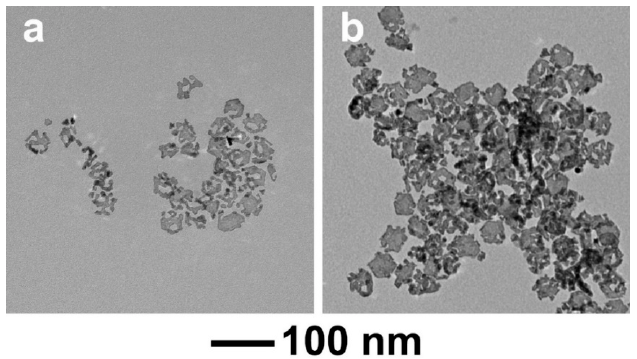
Figure 2. TEM images of the ( a ) Pd 32 Cu 33 Ru 35 and ( b ) Pd 19 Cu 25 Ru 56 nanoplates.